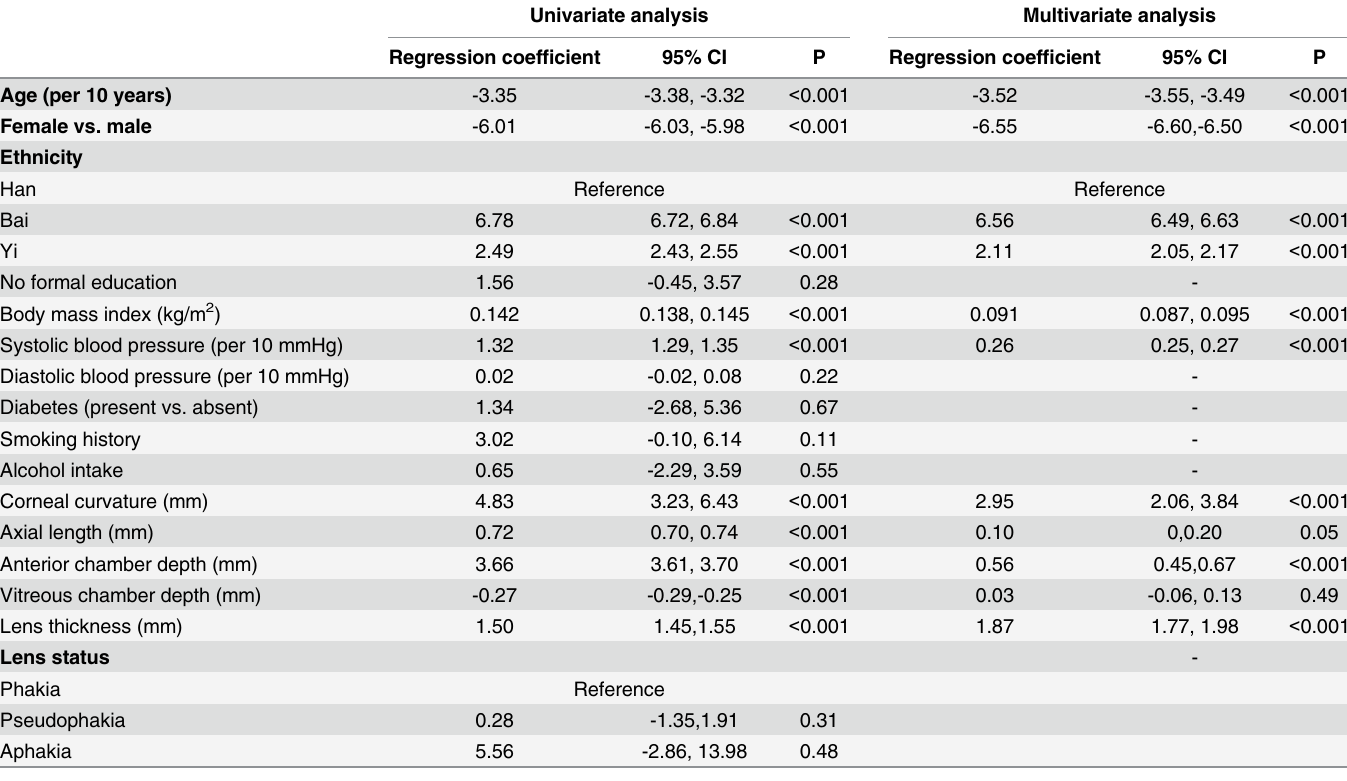
Table 2. Associations of central corneal thickness with systemic and ocular